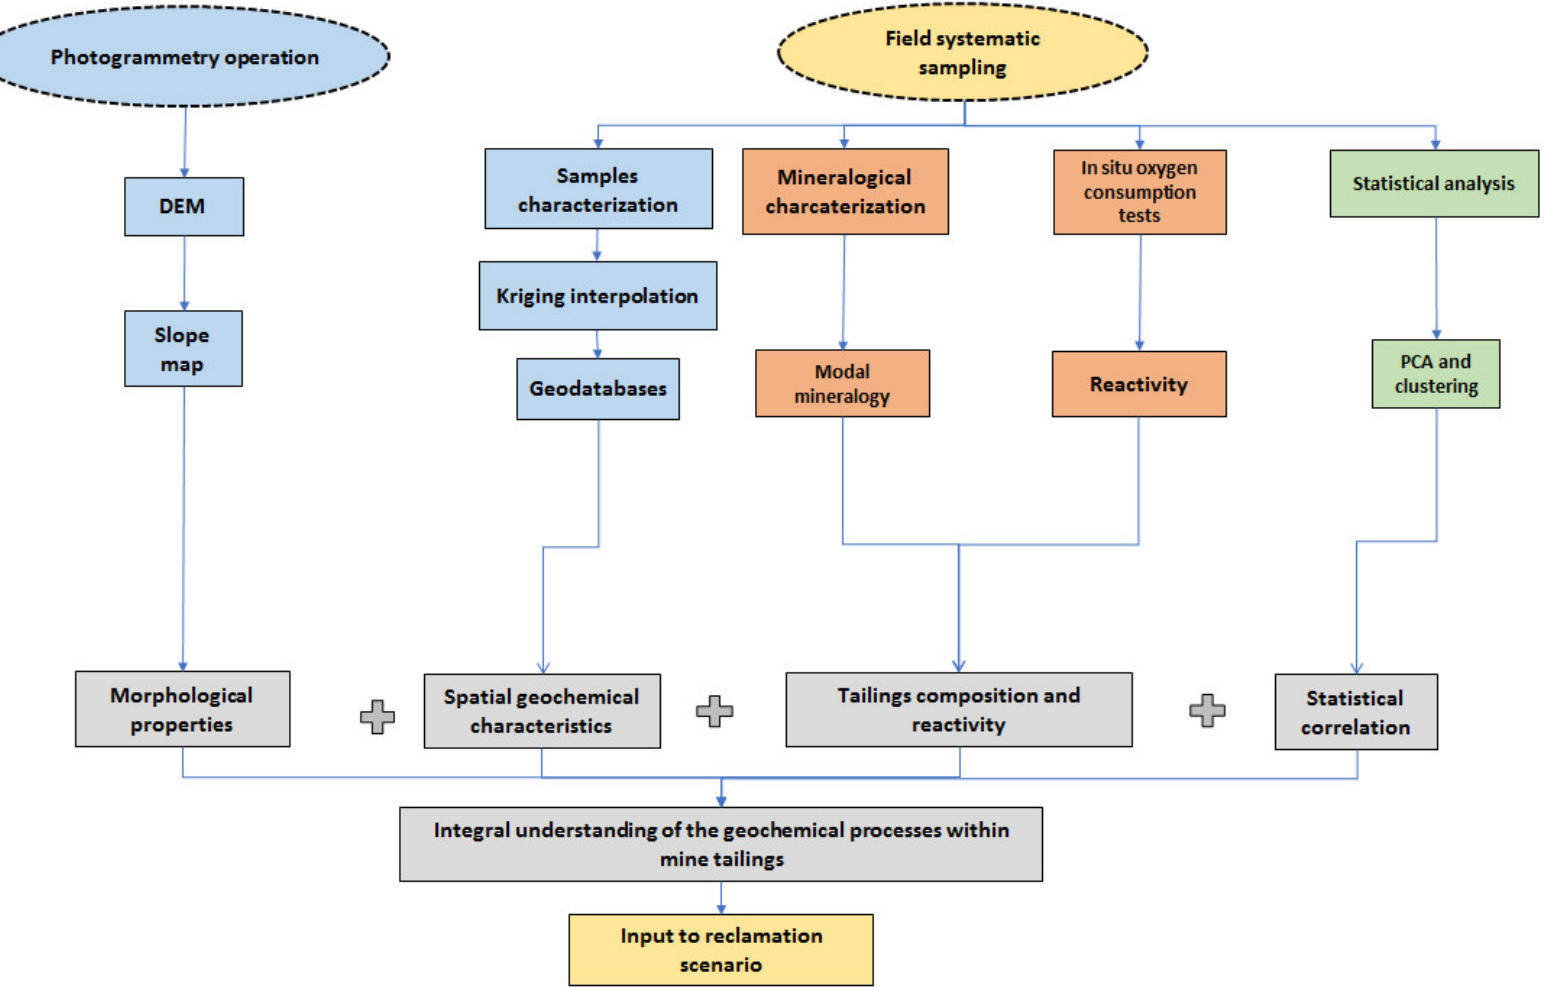
Figure 1. Schematic illustration of the methodological approaches used in this study.